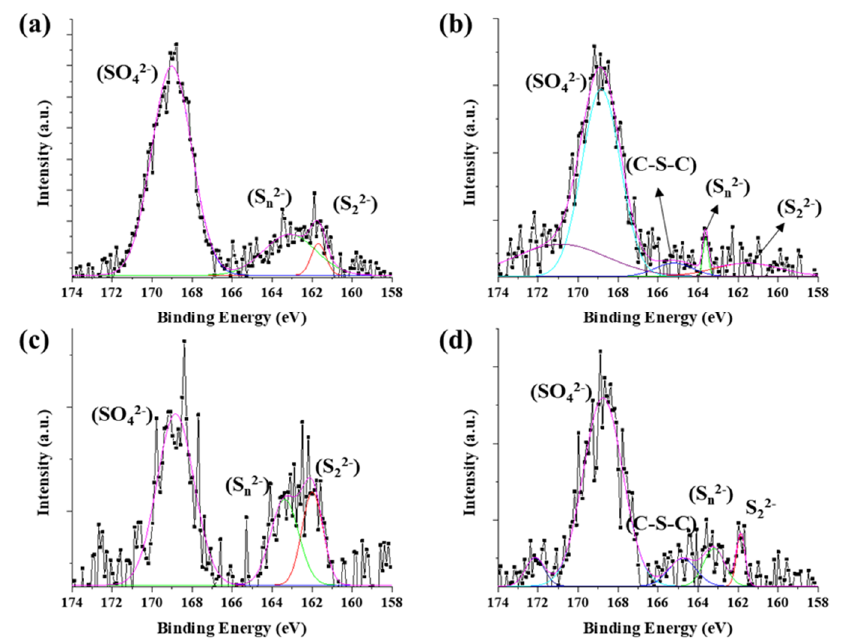
Figure 4. XPS spectra of S 2p on CNT bundle: ( a ) ferrocene, ( b ) acetylferrocene, ( c ) ferrocenemethanol, and ( d ) 1,1′-diacetylferrocene.